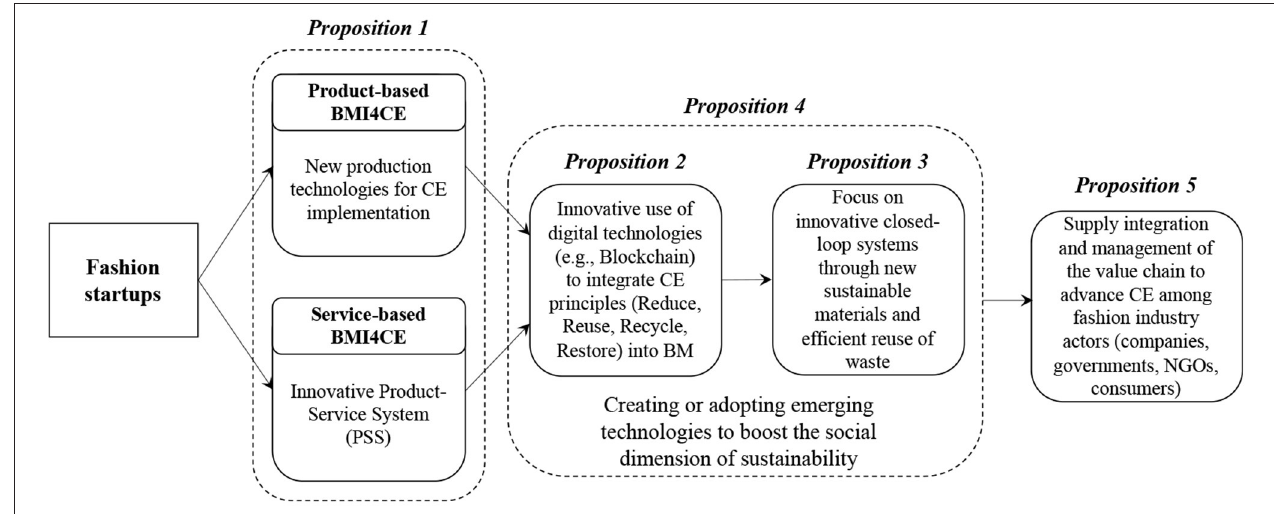
FIGURE 1 | Theoretical framework for fashion startups’ BMI4CE improvement.